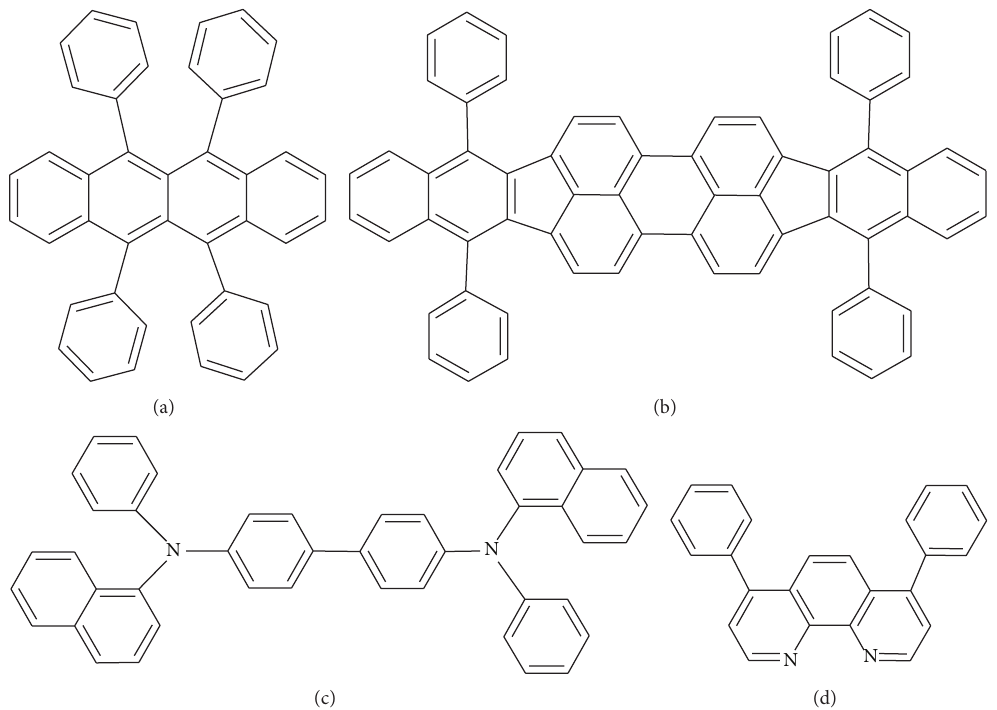
Figure 3: Chemical structure of (a) rubrene, (b) DBP, (c) NPB, and (d) BPhen.